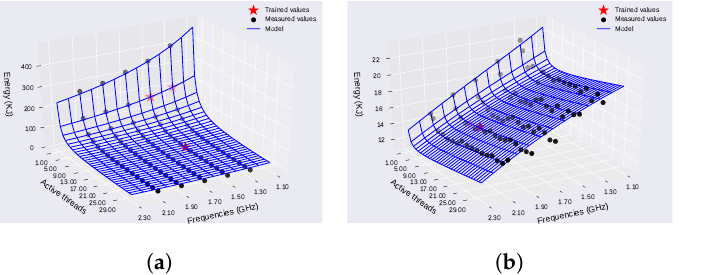
Figure 6. Example fit for a specific input size: Blackscholes ( a ) and Canneal ( b ). “measured values” are the sensor data, and “minimum energy” is the minimum energy model